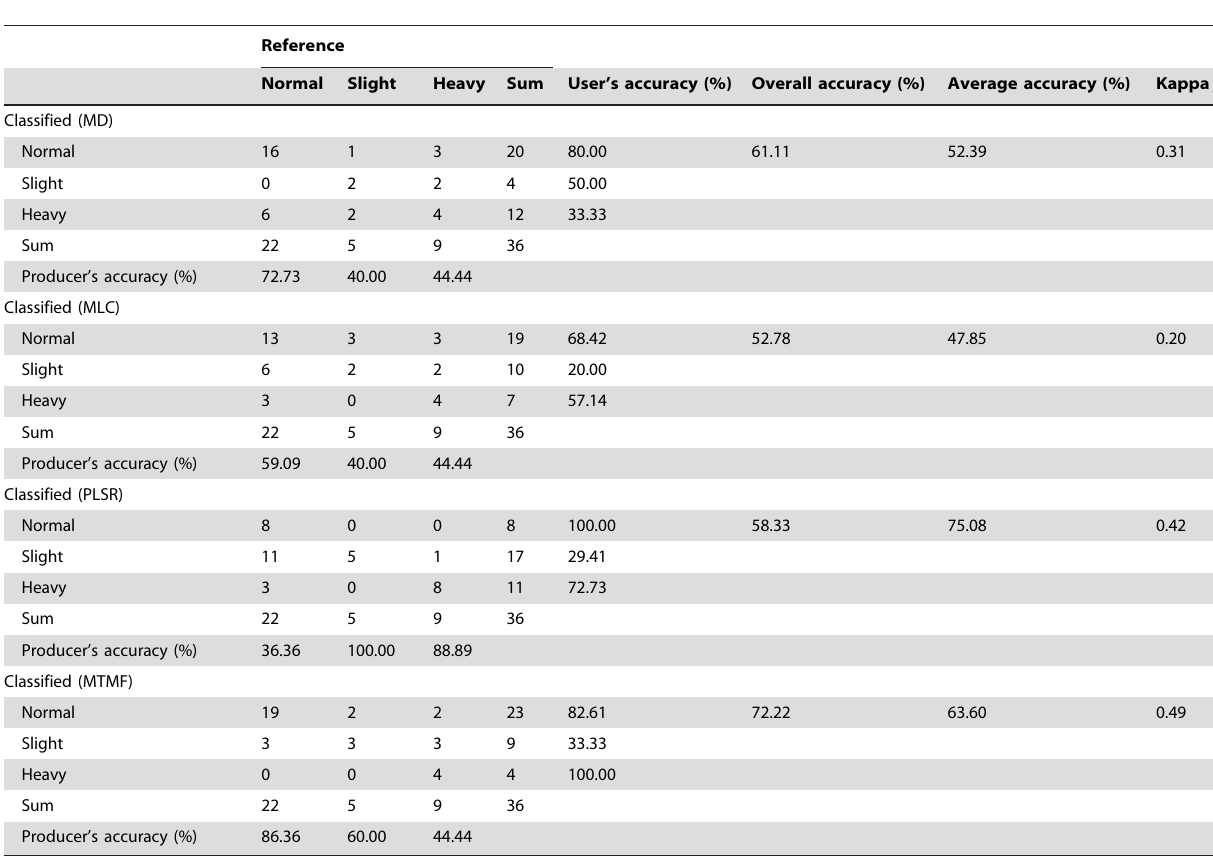
Table 5. Confusion matrices and classification accuracies produced by the four methods with test samples ( n =36).